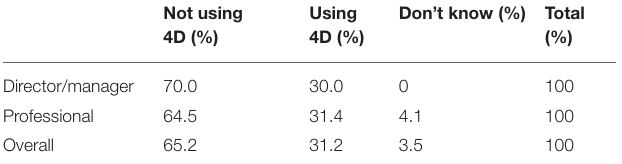
TABLE 7 | Use of 4D in